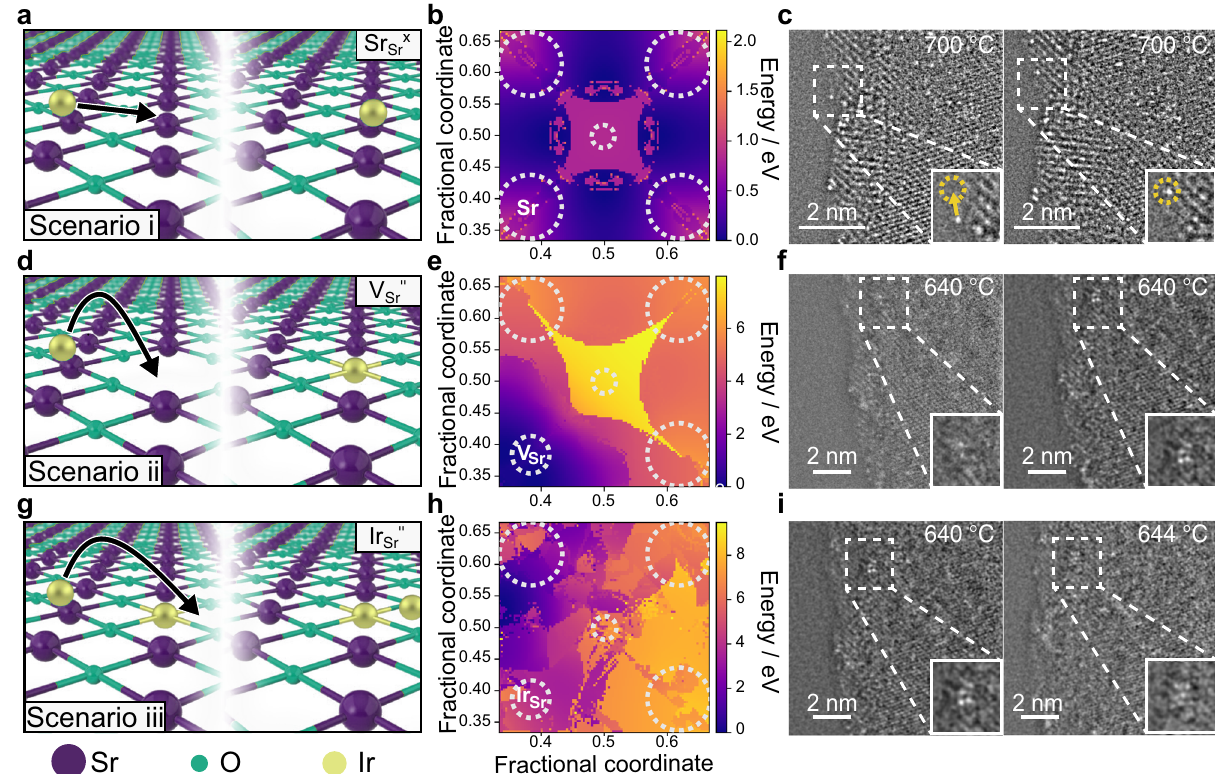
Fig. 1 | Evaluation of the Ir nanoparticle nucleation mechanism at the initial stagesofexsolutioninastoichiometricIr-dopedSrTiO 3 perovskite. Schematics ofthethreeconsideredIrmigrationscenariosofaslabmodel(001)SrTiO 3 surface: a migrationwithnodefects(scenarioi,Sr Sr x ), d migrationwithasurfaceSrvacancy (scenarioii,V Sr ” ), g andmigrationwhereanotherIr +3 ionhassubstitutedasurfaceSr ion (scenario iii, Ir Sr ” ). Ir, Sr, and O are represented by gold, purple, and green atoms, respectively. b , e , h Energy pro fi les of the Ir 3+ ion over the three surface models represented in ( a , d , g ), respectively, with dotted circles to indicate the atomic positions (Sr: corner sites, O: centre, V Sr ” or Ir Sr ” : bottom left in ( e ) and ( h ), respectively),ascanbealsovisualisedinthetop-viewatomicslabinSupplementary